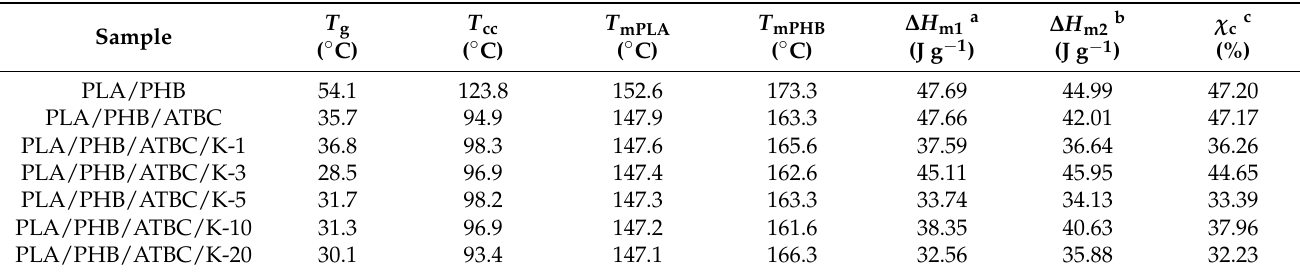
Table 1. Parameters obtained from DSC heating records of PLA/PHB and PLA/PHB/ATBC neat blends and their keratin composites with different keratin contents varying from 1 to 20